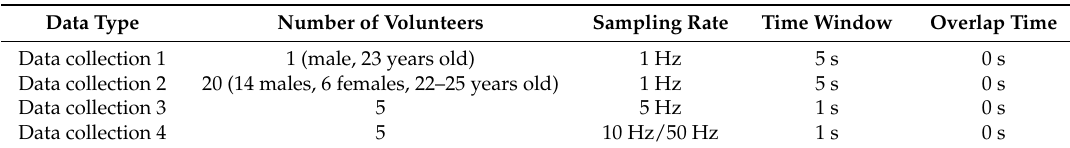
Figure 3. Illustration of the placement of the phone on the participant’s body. Table 1. Data collection of four experiments.